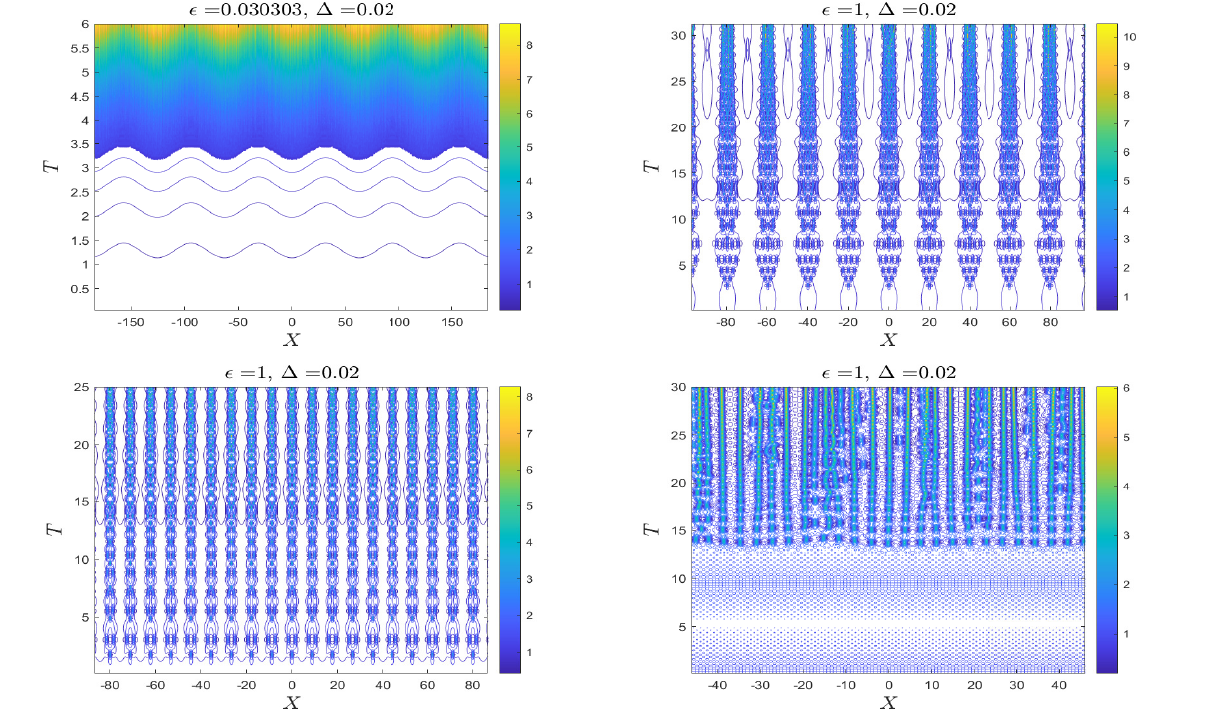
Figure 18. Case 4: The initial condition is (14) with ∆ = 0.02. Contour plots of | Q | when M = 0.1, (cid:101) = 1/33, K = 0.1 ( top left ), M = 1, (cid:101) = 1, K = left ), and M = 1, (cid:101) = 1, K = 4 ( bottom right ).